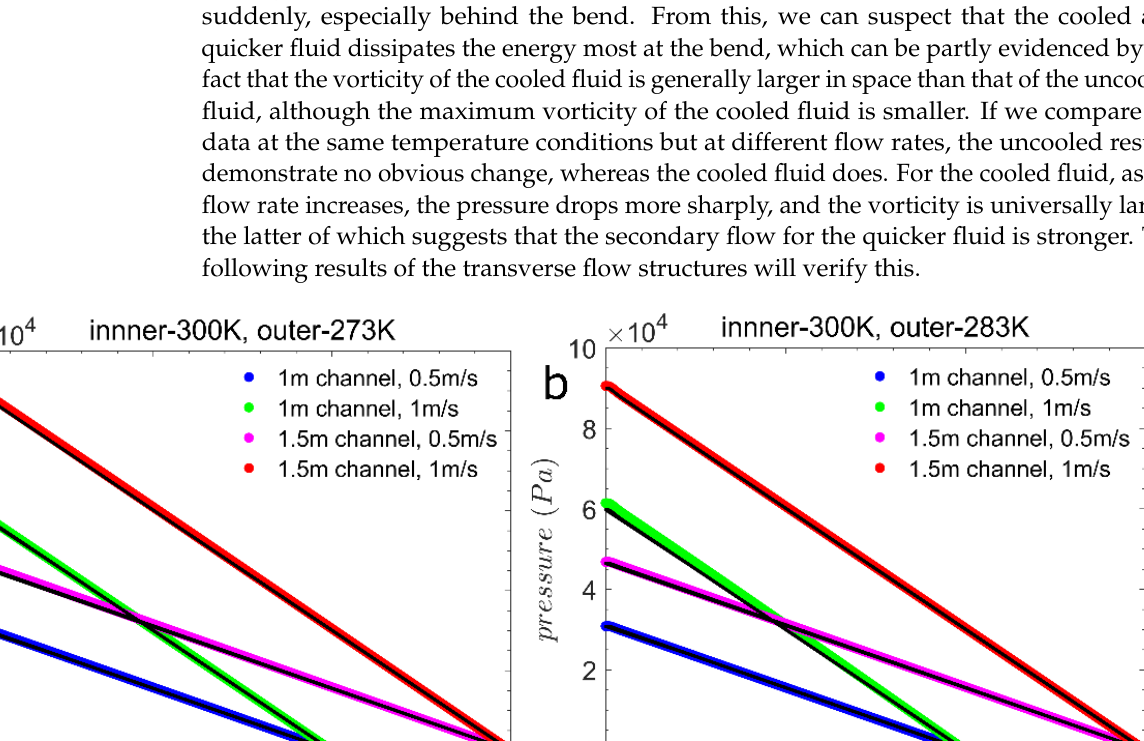
Figure 3. The temperature distributions at the outlet of the straight channels. The upper row shows the results at the temperature boundary conditions of incoming fluid at the inlet-300 K, channel wall-273 K. The lower row shows the results at the temperature boundary conditions of incoming fluid at the inlet-300 K, channel wall-283 K. The left two columns show the results in the 1 m long channel. The right two columns show the results in the 1.5 m long channel. Within each element of the quadrigram, the left one shows the result at the inlet velocity of 0.5 m/s, and the right one shows the result at the inlet velocity of 1 m/s.